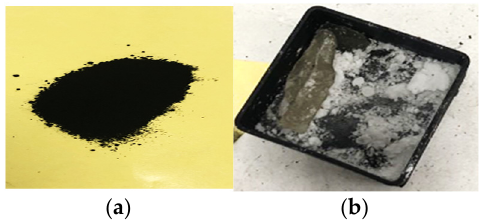
Figure 3. Material composition of the rough sea surface. The density of carbon black is 2.00 g/cm 3 and the density of paraffin is 0.90 g/cm 3 . ( a ) Carbon black; ( b )